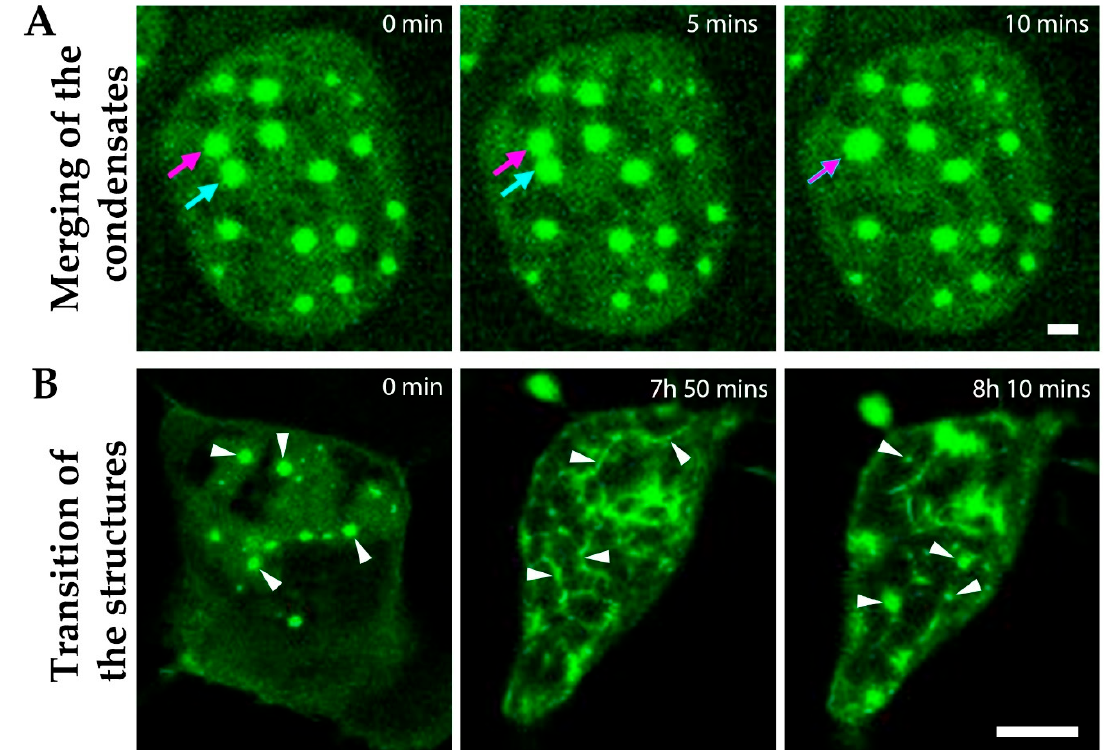
Figure 7. MPRIP condensates show typical features of liquid-like structures. Live cell imaging showing the nucleus of an U2OS cell over-expressing GFP-MPRIP. ( A ) The GFP-MPRIP condensates were visualized for 15 min. Arrows show the structures that merge during the imaging. Green is GFP-MPRIP. Scale bar represents 3 µm. ( B ) The GFP-MPRIP expressing cell was visualized for 8 h and 10 min. Arrowheads show the spherical condensates that disappear and form fibers, and then revert back into condensates over time. Imaging started at the 12th hour after transfection. The scale bar represents 10 µm.